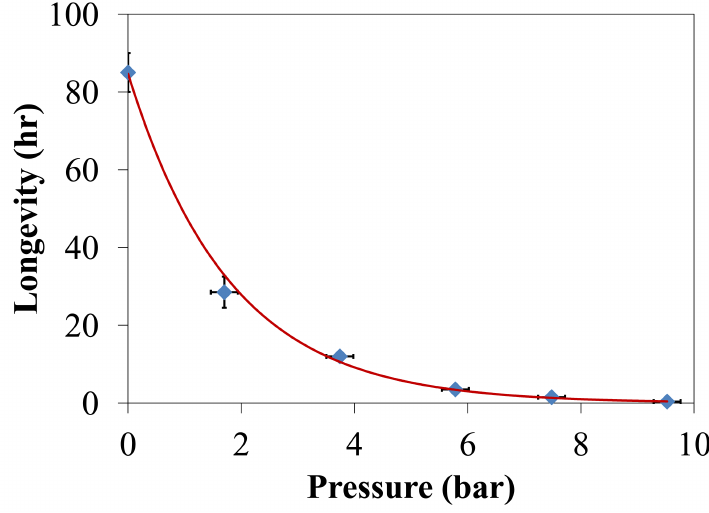
Figure 38. Effect of elevated pressure on longevity of superhydrophobic fibrous coating. Solid line is exponential fit of experimental data. From Samaha et al.